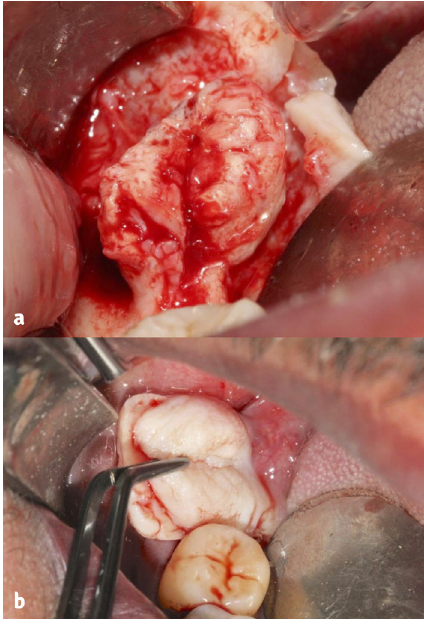
Fig. 4. Intraoperative view a: isolated osteoma. b: mucosal membrane.